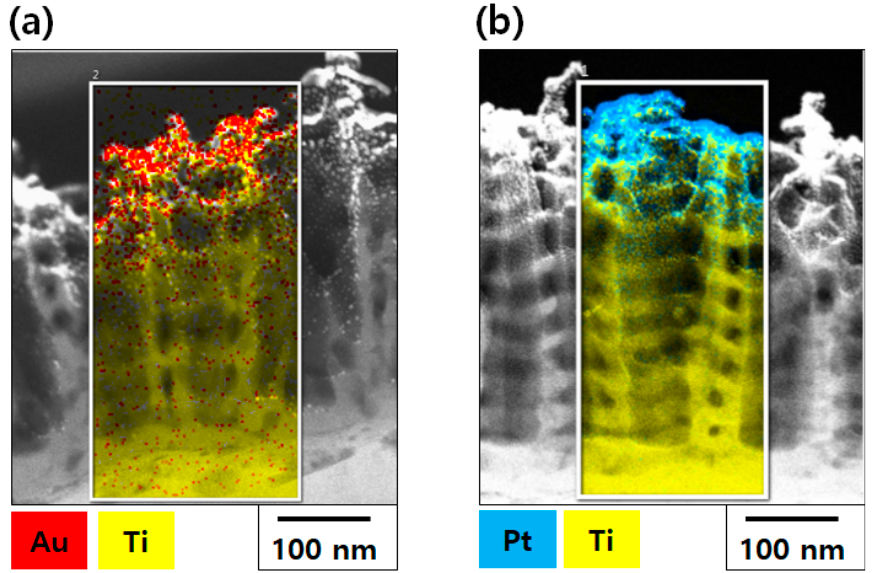
Figure 3. Transmission Electron Microscope (TEM) images of ( a ) Au–TiO 2 NTs (1 min of Au sputtering) and ( b ) Pt–TiO 2 NTs (1 min of Pt sputtering).